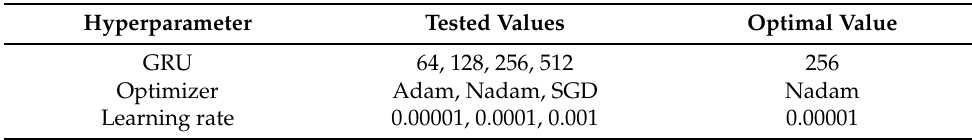
Table 2. The hyperparameter tuning of RoBERTa-GRU model.